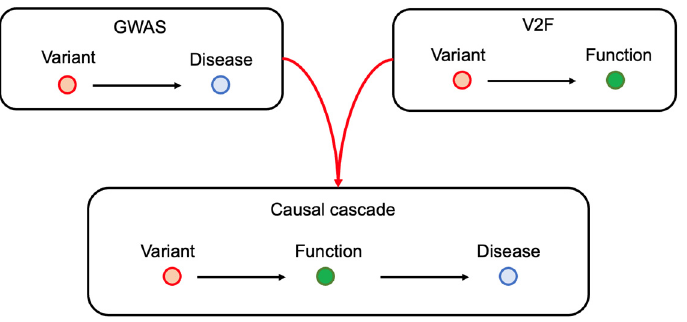
Figure 1. The V2F study illuminates the causal cascade of autoimmunity. The GWAS connects variants and diseases. V2F studies link variants and function. The function can be any immune-related phenotypes. The most studied and feasible phenotype is gene expression levels in immune cells. By combining GWAS and V2F outputs, we can draw the causal cascade.